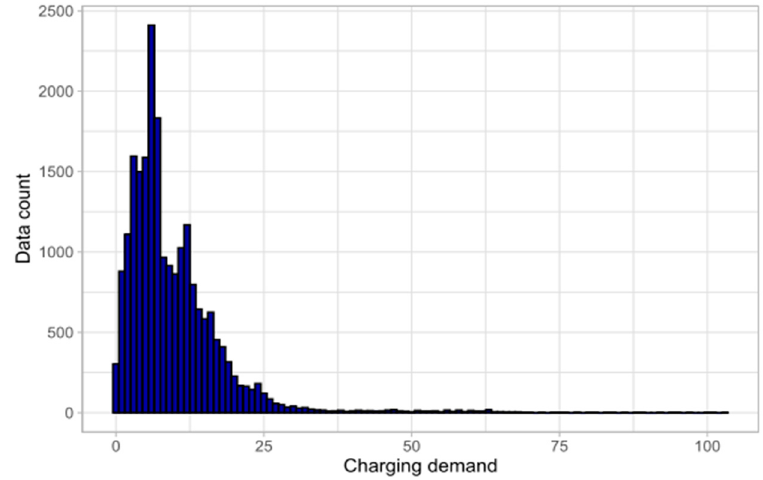
Figure 3. Histogram of charging demand per session, at 1 kWh intervals.